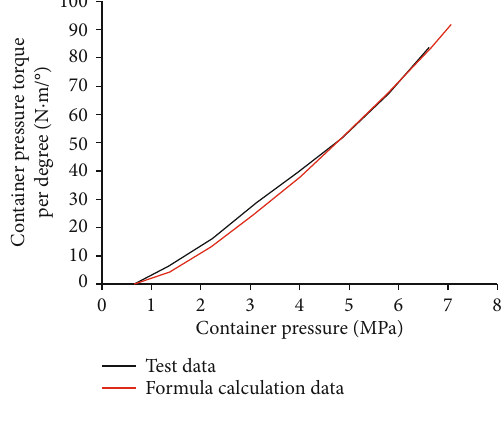
Figure 12: Joint number